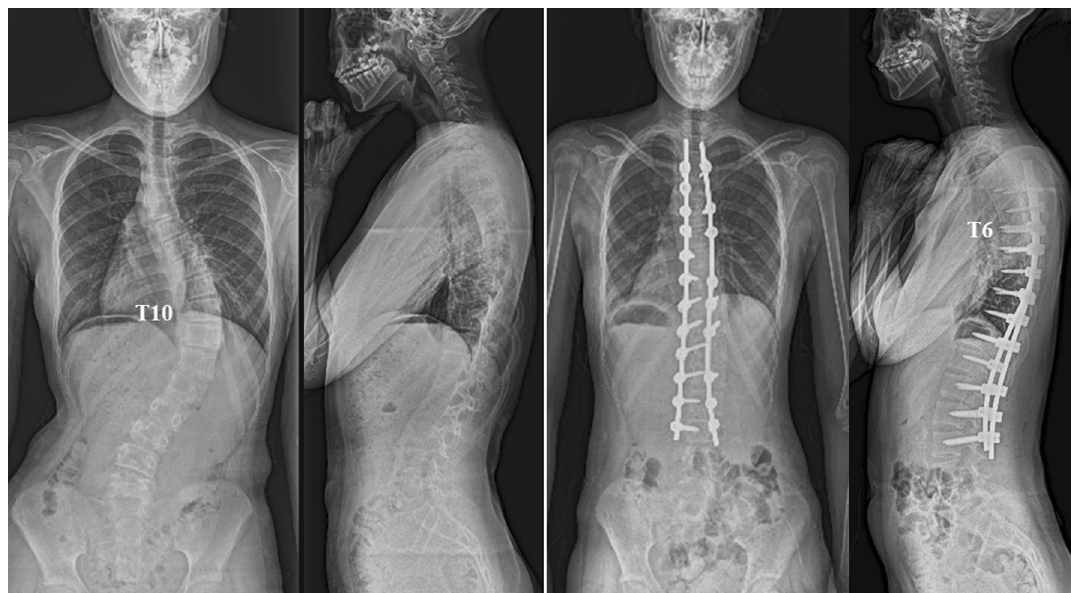
Figure 6. Anatomical spinal reconstruction using notch-free, pre-bent rods in a patient with Lenke 1A-thoracic adolescent idiopathic